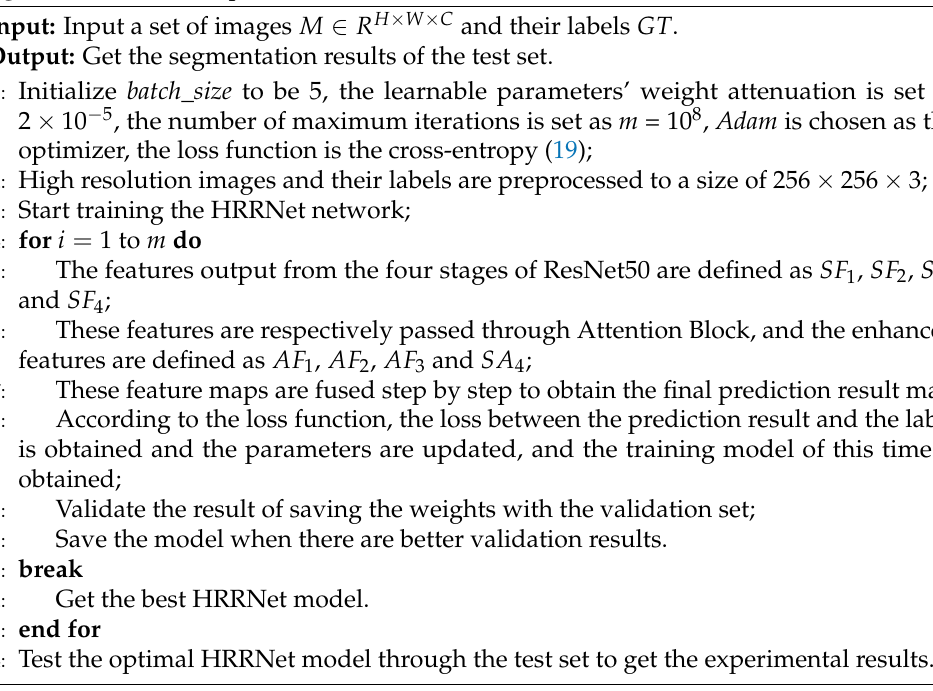
Algorithm 1 Train an optimal HRRNet